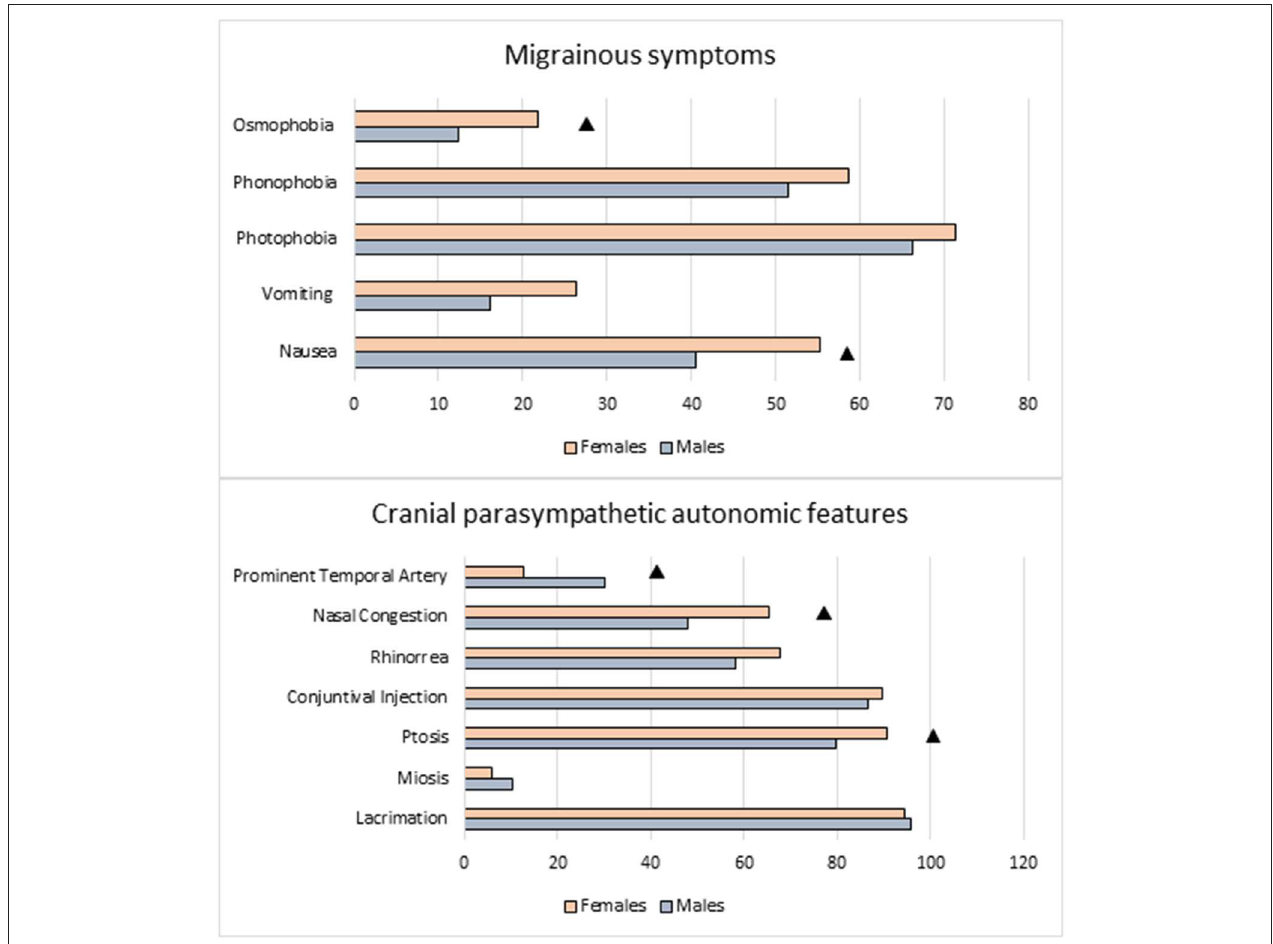
FIGURE 1 | Migraine-like and trigeminal autonomic symptoms: comparison between sexes. N Females vs. Males: p <